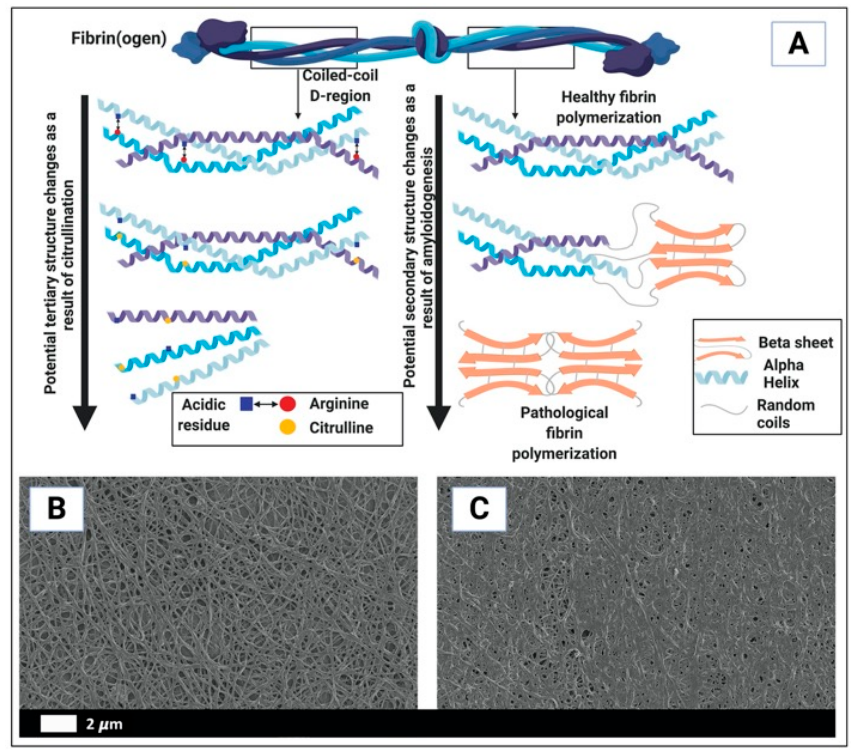
Figure 3. Differences in healthy and pathological clotting biochemistry [76]. ( A ) The uncoiling of the fibrin(ogen) protein (in part) resulting in whole blood and plasma hypercoagulability. ( B , C ) are examples of scanning electron microscopy micrographs of ( B ) polymerized fibrin cross-linking fibrin clot from a healthy individual (created with platelet poor plasma with added thrombin); ( C ) fibrin clot from a diabetes individual (created with platelet poor plasma with added thrombin) (( B,C ) reprinted from [76]). Image in ( A ) created with BioRender (https://biorender.com/ (accessed on 15 Octo- ber 2021)). The value of using both the TEG ® and fluorescence markers was again seen in our recent studies on the effects that COVID-19 has on the coagulation system, where an in- creased clot strength and anomalous microclot formation were observed [21,22]. 2. The Early Treatment of Patients with Anticoagulation Medication Early on in the disease, it was suggested that best practices for supportive manage- ment of acute hypoxic respiratory failure and (ARDS can be followed [1,83]. In 2020, the American Thoracic Society-led international task force has also released a guidance doc- ument to help clinicians manage COVID-19. The new guidance—“COVID-19: Interim Guidance on Management Pending Empirical Evidence”—is published as an open access document on the American Thoracic Society’s website (https://www.tho- racic.org/covid/covid-19-guidance.pdf (accessed on 15 October 2021)) [84]. These guide- lines in broad terms suggest the use of ventilation in patients who have refractory hypox- emia and ARDS, to consider extracorporeal membrane oxygenation in patients who have refractory hypoxemia, COVID-19 pneumonia (i.e., ARDS), and have failed prone ventila- tion. Most significant is that the guidelines recognize and state that: “We believe that in